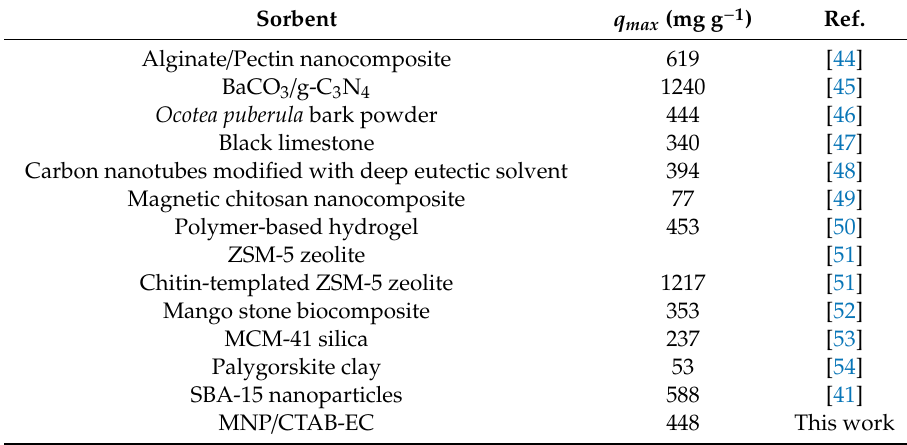
Table 7. Comparison of the maximum adsorption capacities ( q max ) of various reported sorbents for CV.